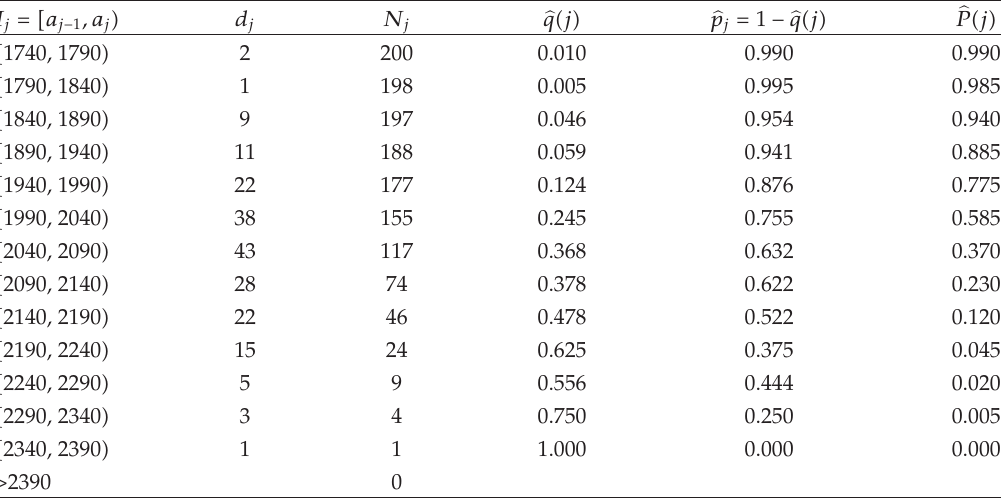
Table 6: Estimation result of the capacity distribution for the inside lane.